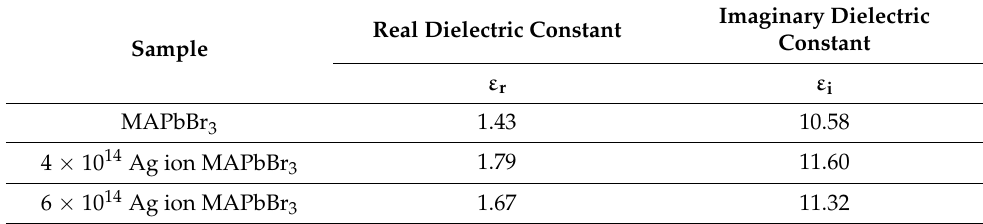
Table 2. ε r and ε i of undoped MAPbBr 3 and Ag ion-implanted MAPbBr 3